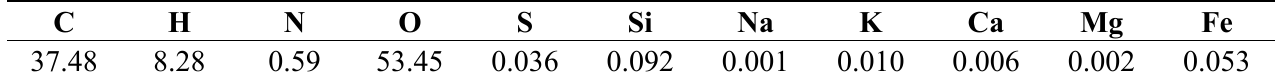
Table 1. Elemental composition of the BO.